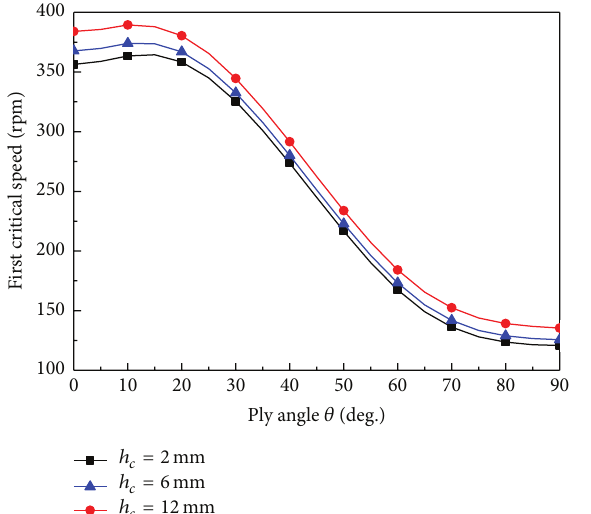
Figure 10: The critical speed versus fiber angle for various thick- nesses of constraining layer ( ℎ V = 2 mm).